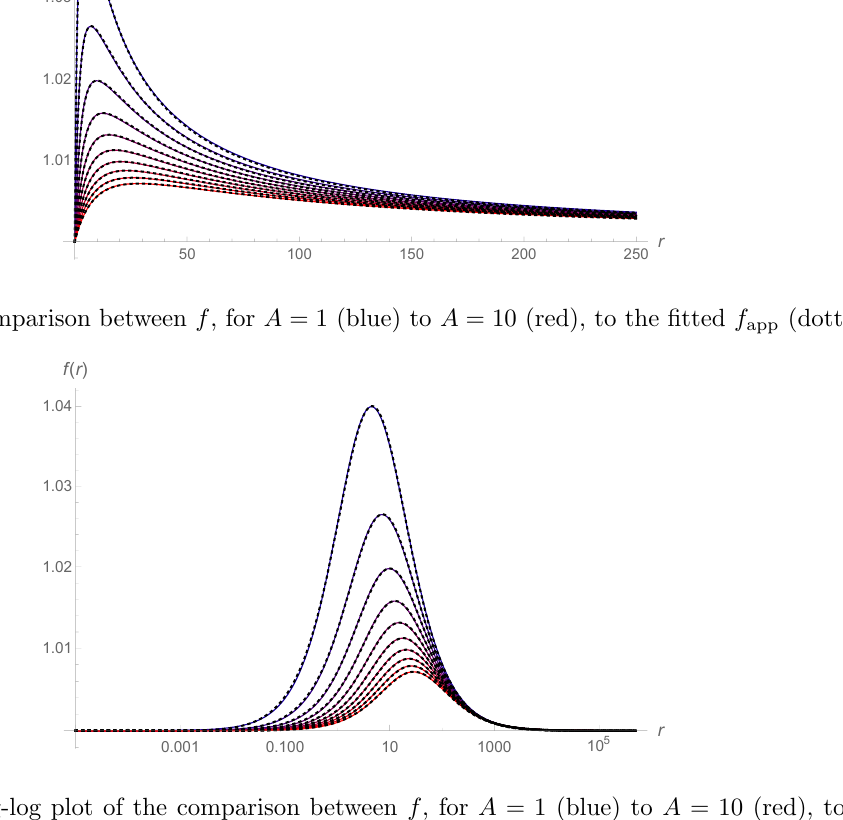
Figure 12 . Log-log plot of the comparison between f , for A = 1 (blue) to A = 10 (red), to the (cid:12)tted f app